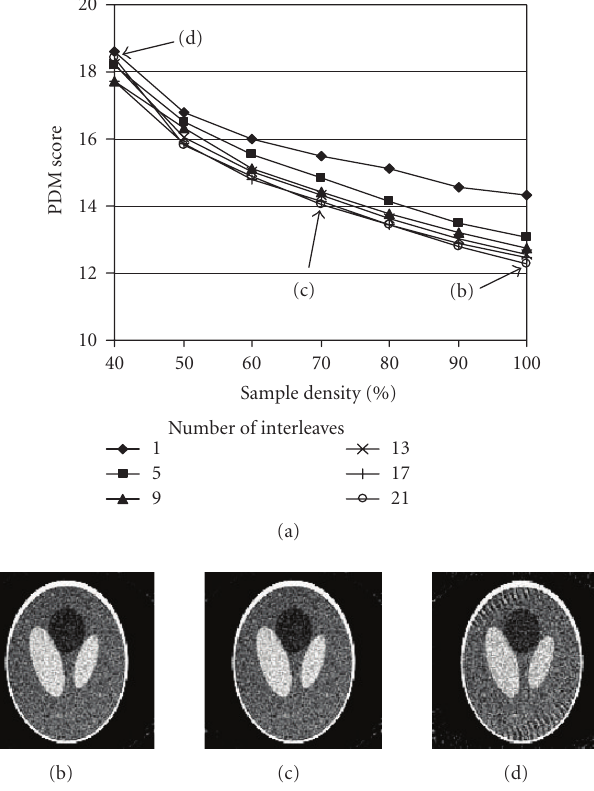
Figure 10: E ff ect of number of interleaves and sampling densities. In (a), PDM is plotted as a function of the sampling densities from 40% to 100% and 6 di ff erent numbers of interleaves. Other conditions (Voronoi method, conventional regridding, noise = 3) were held constant. Images in (b), (c), and (d) correspond to 100% sample, 70% sample, and 40% sample and 21 interleaves, respectively, as